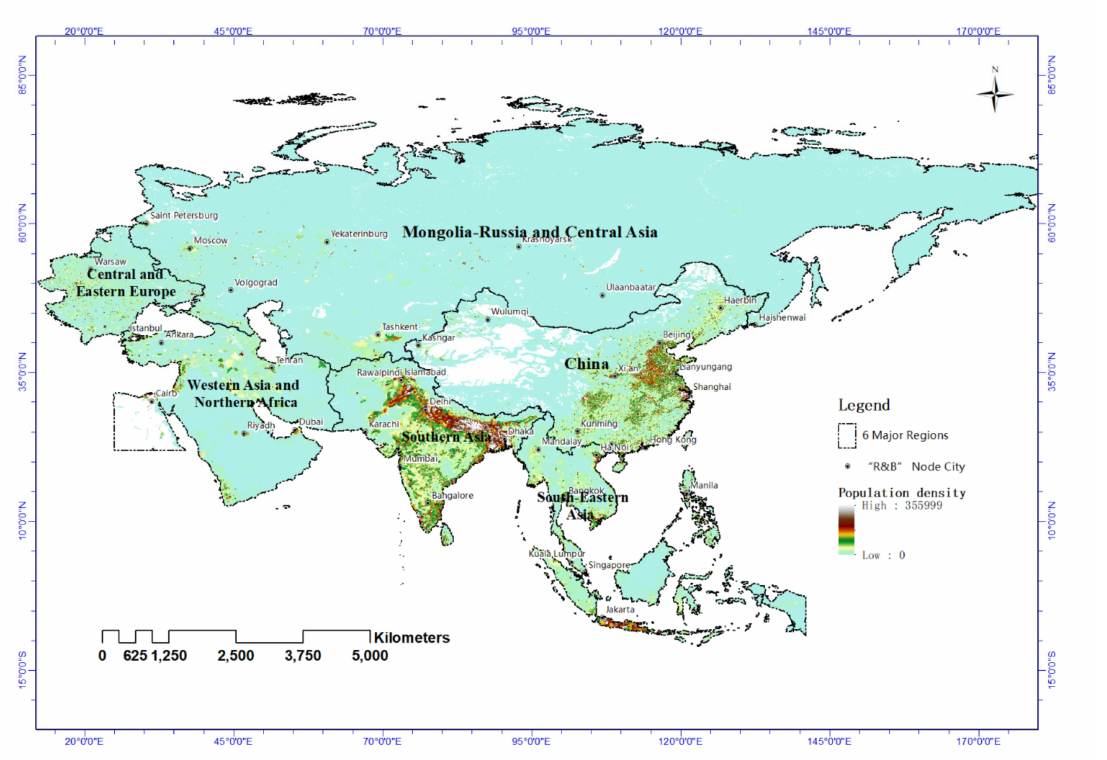
Figure 10. “Belt and Road” zone population density map.